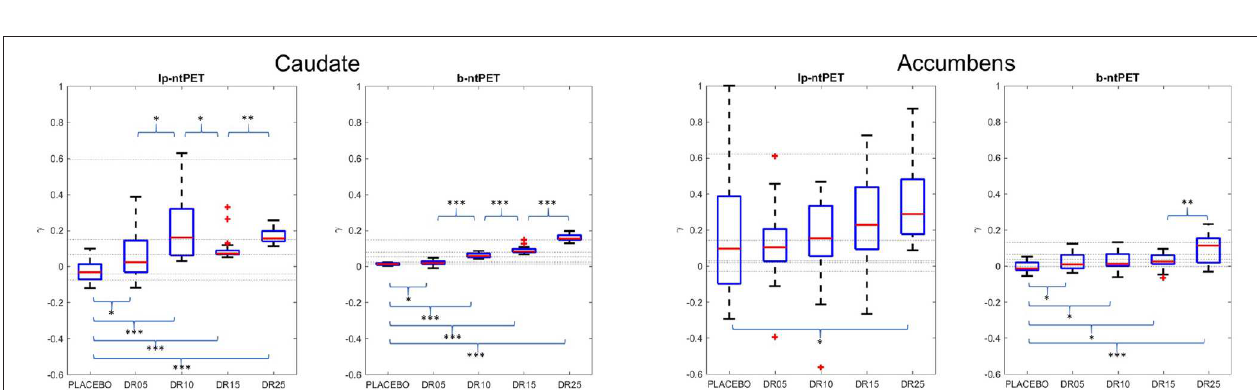
FIGURE 7 | Accuracy of the estimations of the kinetic parameters ( R 1 , k 2 , and k 2 a ) with lp-ntPET and b-ntPET. The relative errors (in %) on the estimations are given for each condition. (Left) , caudate; (Right) , accumbens. Whiskers represent 1.5 times the IQR.